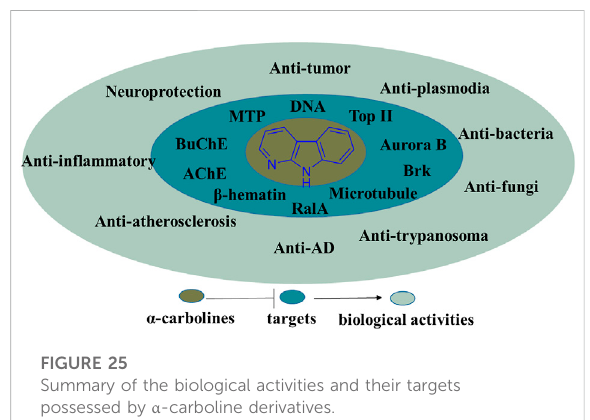
FIGURE 25 Summary of the biological activities and their targets possessed by α -carboline